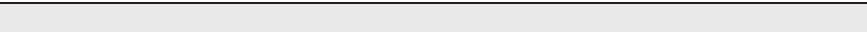
Table 1. Calculated parameter estimates for von Bertalanffy’s growth curves for harbour seals in Svalbard. L ∞ and M ∞ are the asymptotic length (cm) and mass (kg) respectively, a determines the rate of approach to the asymptote and b determines the curvelinearity of this approach in the model: L x (or M x )= L ∞ (or M ∞ )[ 1 – e -a (x – x 0 ) ] b . Values are given with SE. (From Lydersen and Kovacs